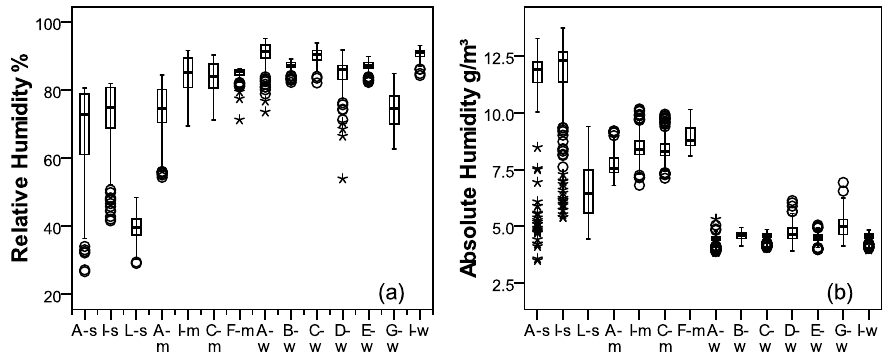
Figure 14. Quartile graphs of interior and exterior air humidity: ( a ) relative humidity, and ( b ) absolute humidity, where -s is the summer period (22–28 August 2011), -m is the transition season period (12– 20 April 2012), and -w is the winter period (15–21 February 2014).